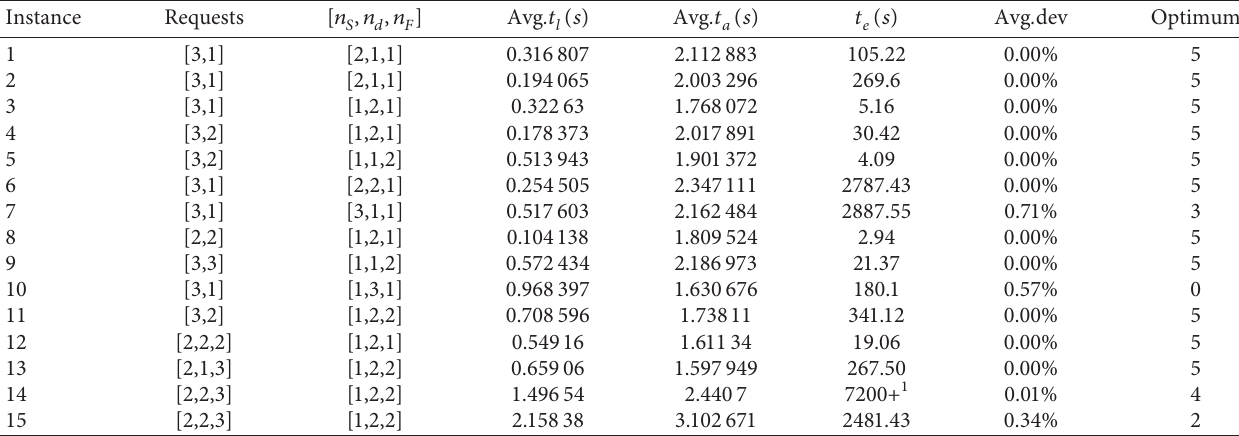
Table 3: Results for small instances.